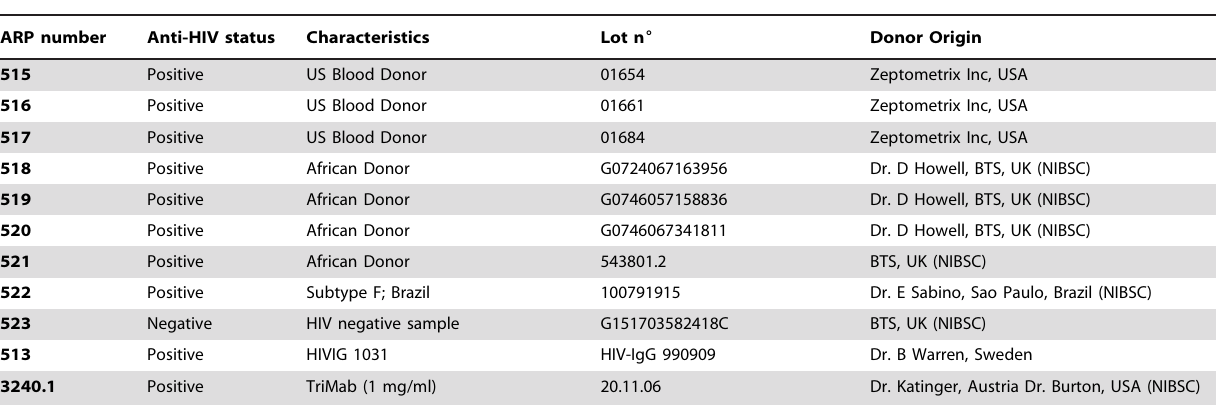
Table 1. List of inhibitory reagents